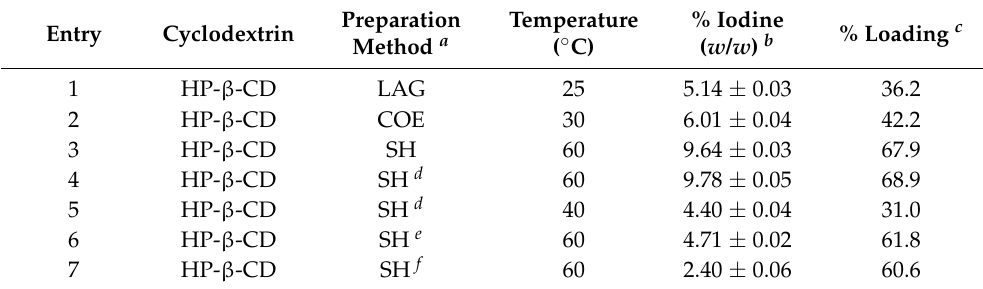
Table 1. Content of iodine in solid complexes with